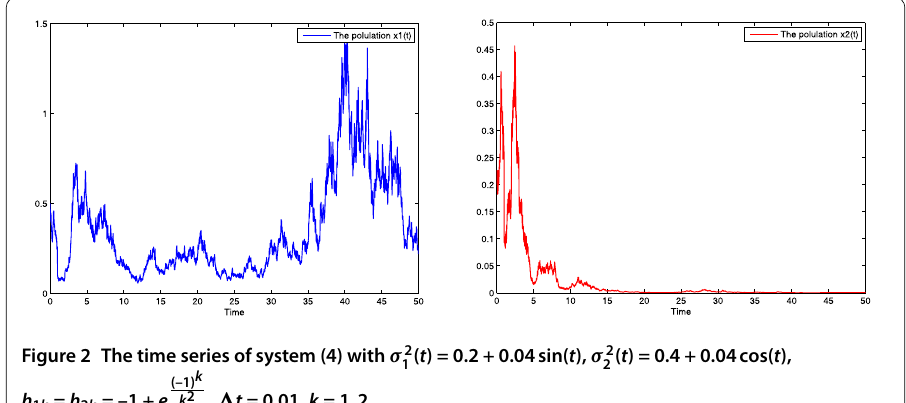
Figure 2 The time series of system (4) with σ 2